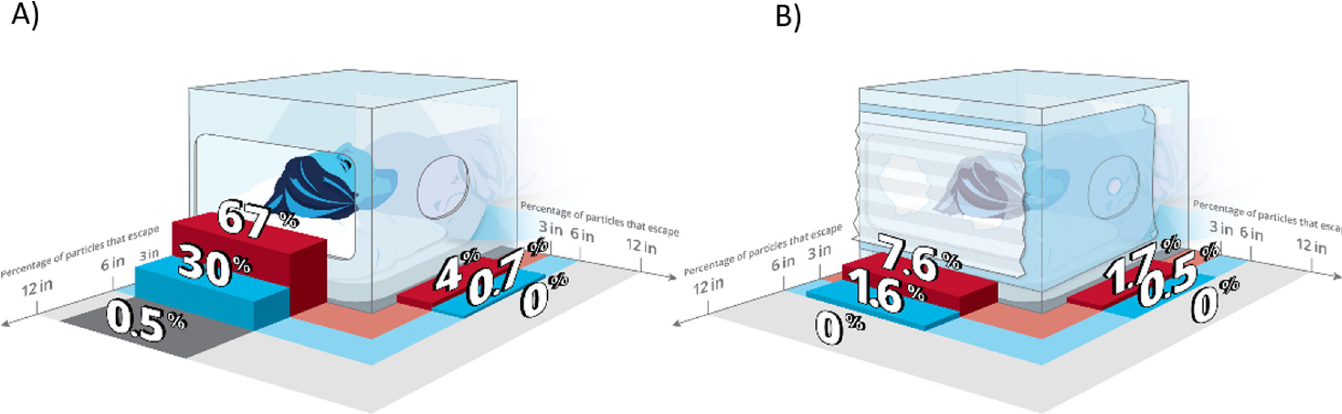
Fig 3. Aerosol particle concentrations as a function of distance from enclosure: Outside particle concentration compared to inside particle number concentration as a function of distance for enclosure (A) without plastic coverings vs. (B) enclosure with dual coverings of furniture wrap and Steri-Drape.